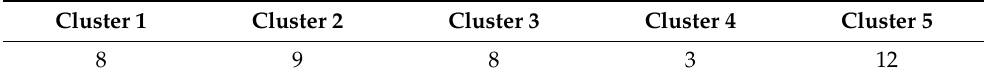
Table 2. Number of cases per cluster.